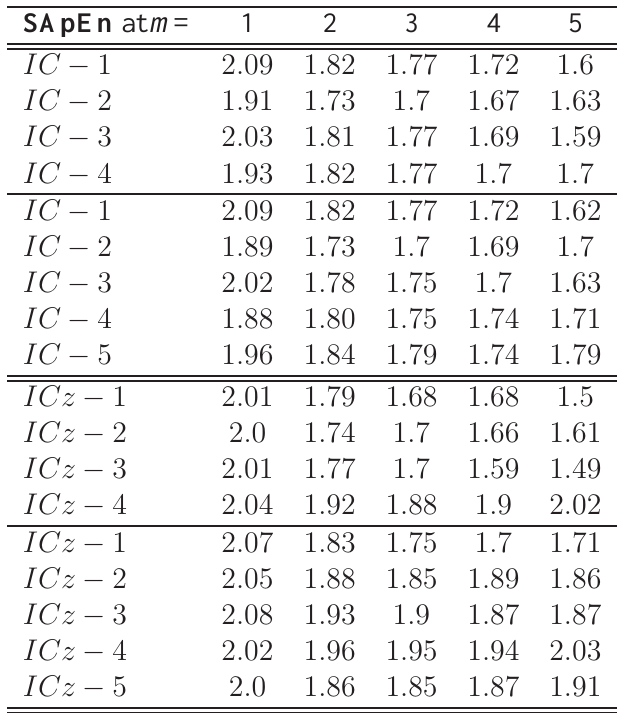
Table 7: Sample Approximate Entropy for each IC and ICz at epoch m = 1 , . . . , 5 . move away from the desired